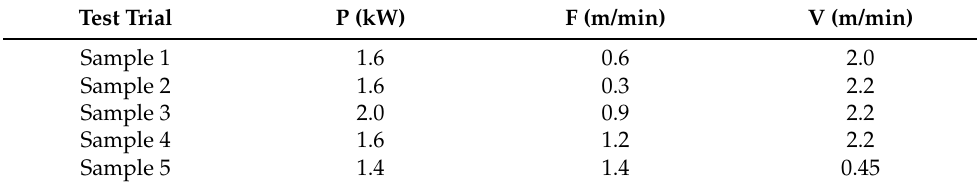
Table 1. First-order deposition parameters.